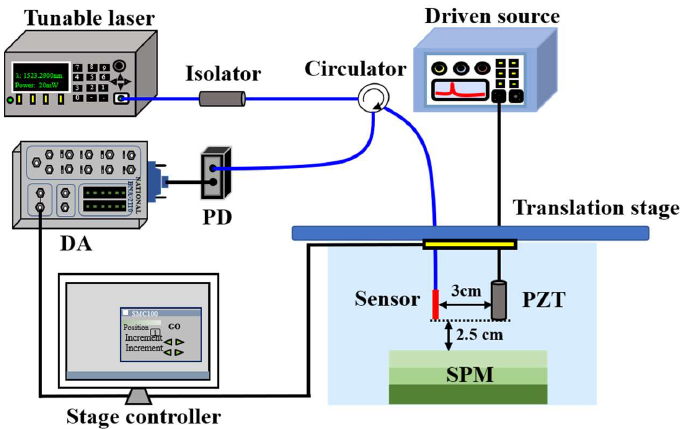
Figure 6. Experimental setup for UW detection and imaging.